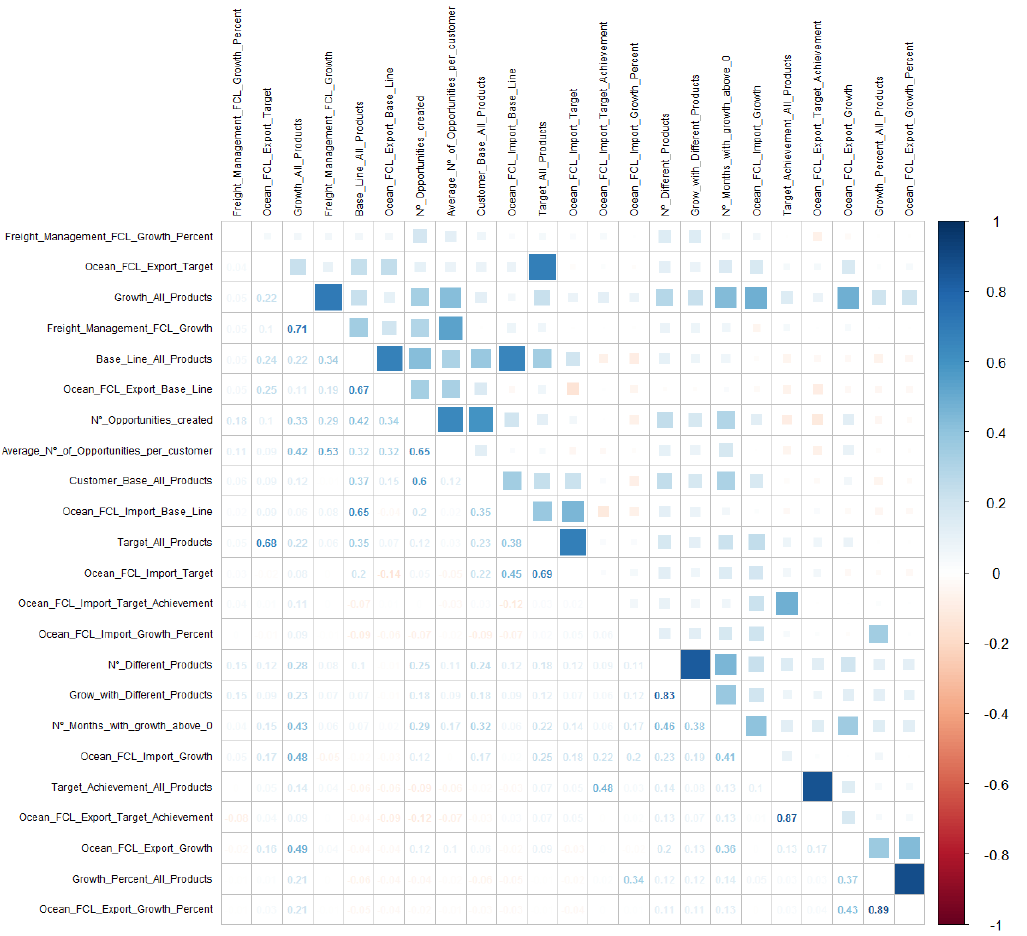
Figure 7. Correlation